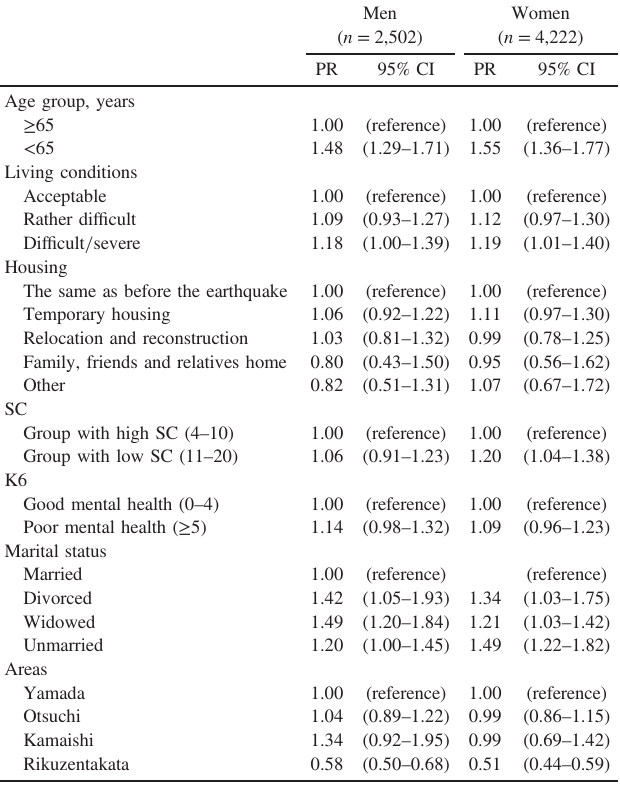
Table 4. Prevalence ratios for poor dietary intake and related factors using Poisson ’ s regression